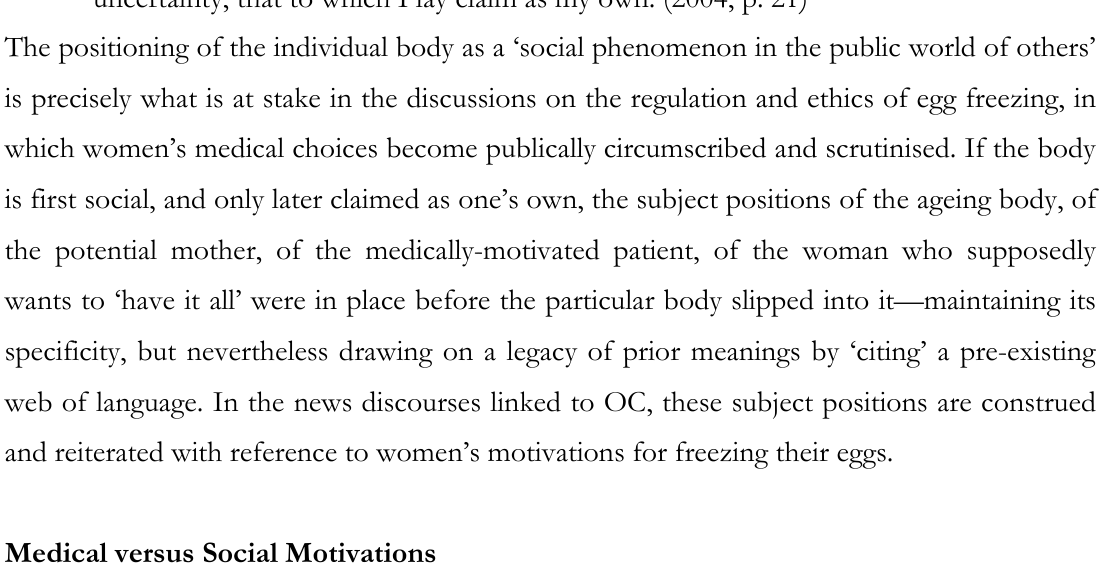
Lucy van de Wiel, For Whom The Clock Ticks: Reproductive Ageing and Egg Freezing in Dutch and British News